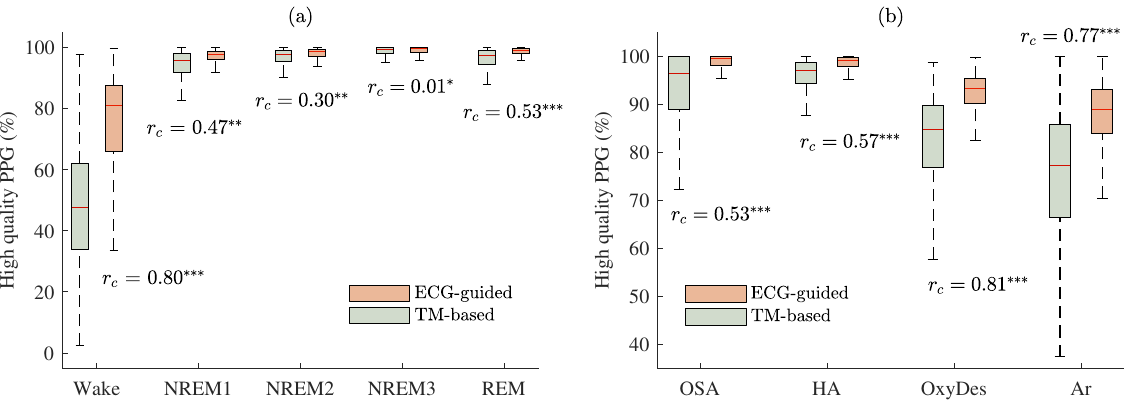
Figure 8. The proportion of PPG pulse waves classified as high quality by the two signal-quality as- sessment algorithms with estimated matched-pairs r c values: ECG-guided and TM-based approaches. Results are shown ( a ): whilst awake and for different sleep stages; ( b ) for different events related to sleep-disordered breathing. p < 0.001 and r c < 0.30 is marked ∗ , p < 0.001 and r c ≥ 0.30— ∗∗ , p < 0.001 and r c ≥ 0.50— ∗∗∗ .